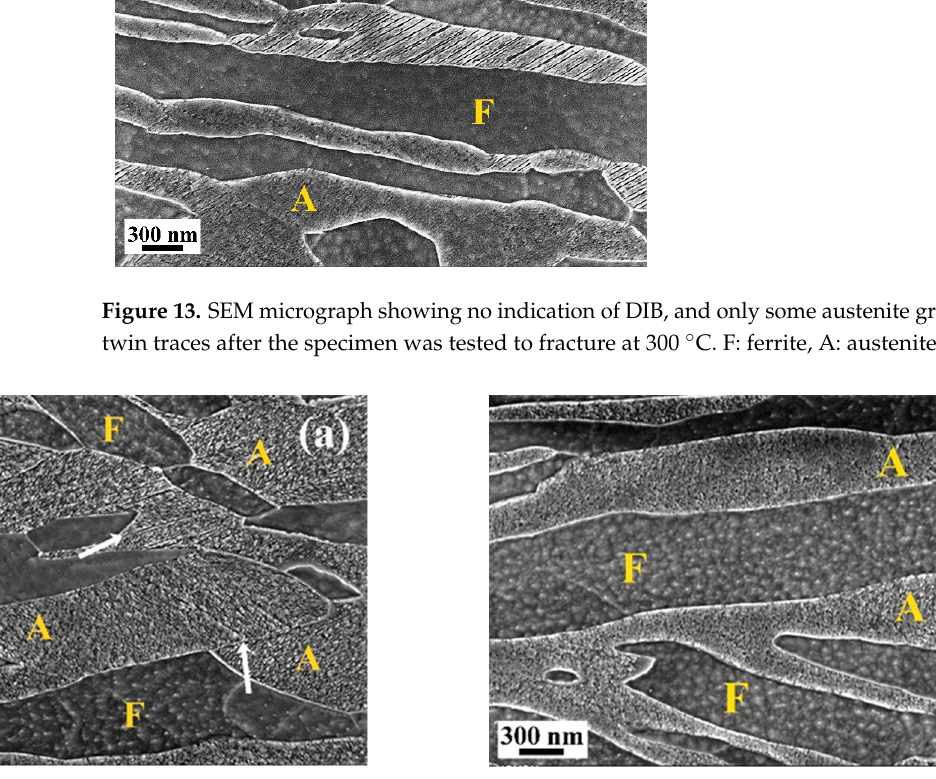
Figure 14. SEM micrographs of a specimen tested to fracture at 350 °C, showing ( a ) low density of twin traces, as marked by arrows and ( b ) austenite grains free of twin trace. F: ferrite, A: austenite.